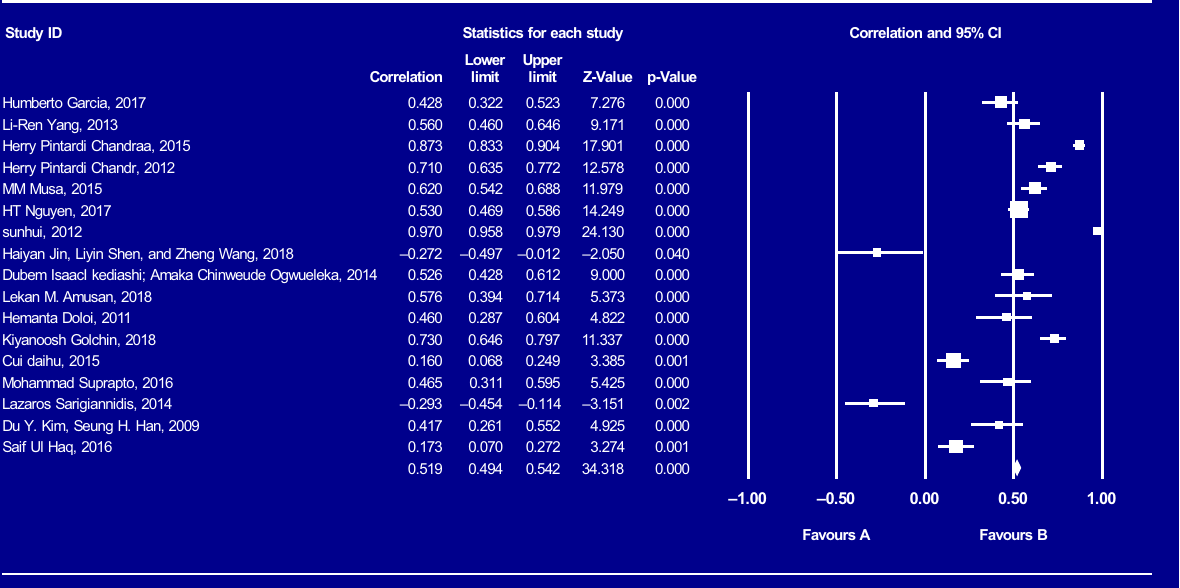
Figure A1. Results of meta-analysis (Quality)